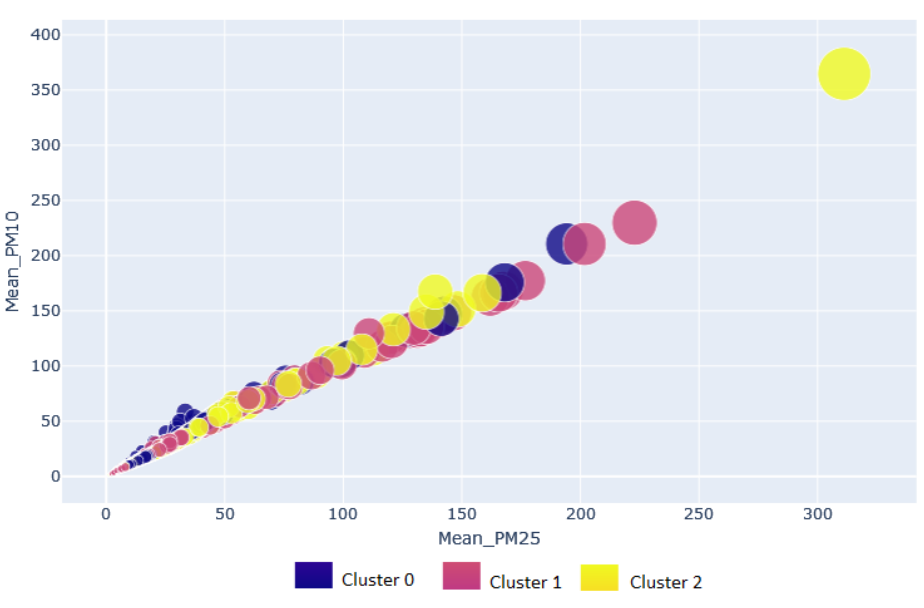
Figure 9. Clustering plot for indoor pollution